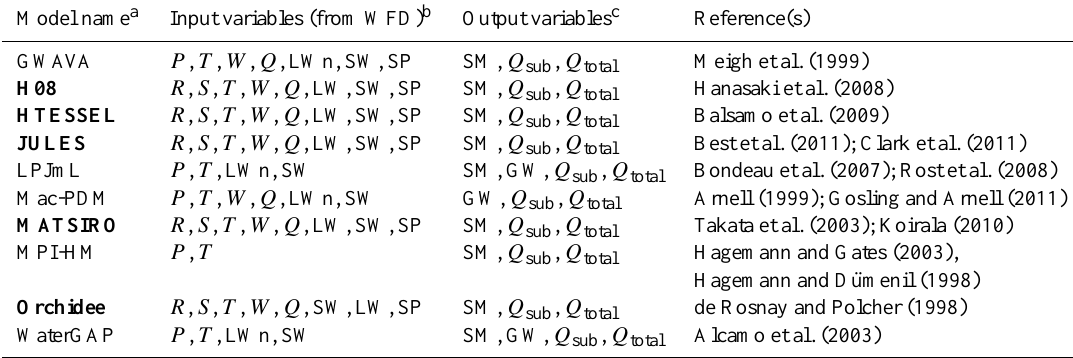
Table 1. Main characteristics of the participating models (derived from Haddeland et al.,